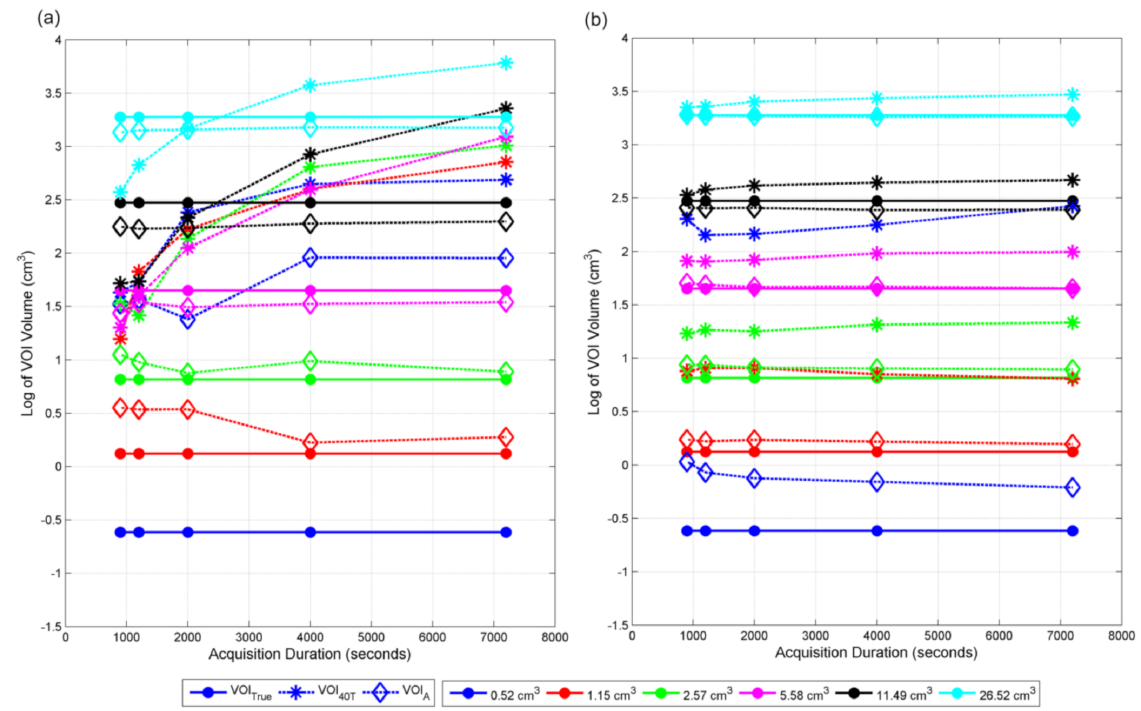
Figure 7. Log of volumes vs. acquisition durations for all six spheres for three segmentation methods (true volume (VOI True ), 40% threshold (VOI 40T ), and adaptive threshold (VOI A )) for contrast 2:1 ( a ) and 4:1 ( b ). Negative sign on y axis represents volume smaller than 1 cm 3 in log